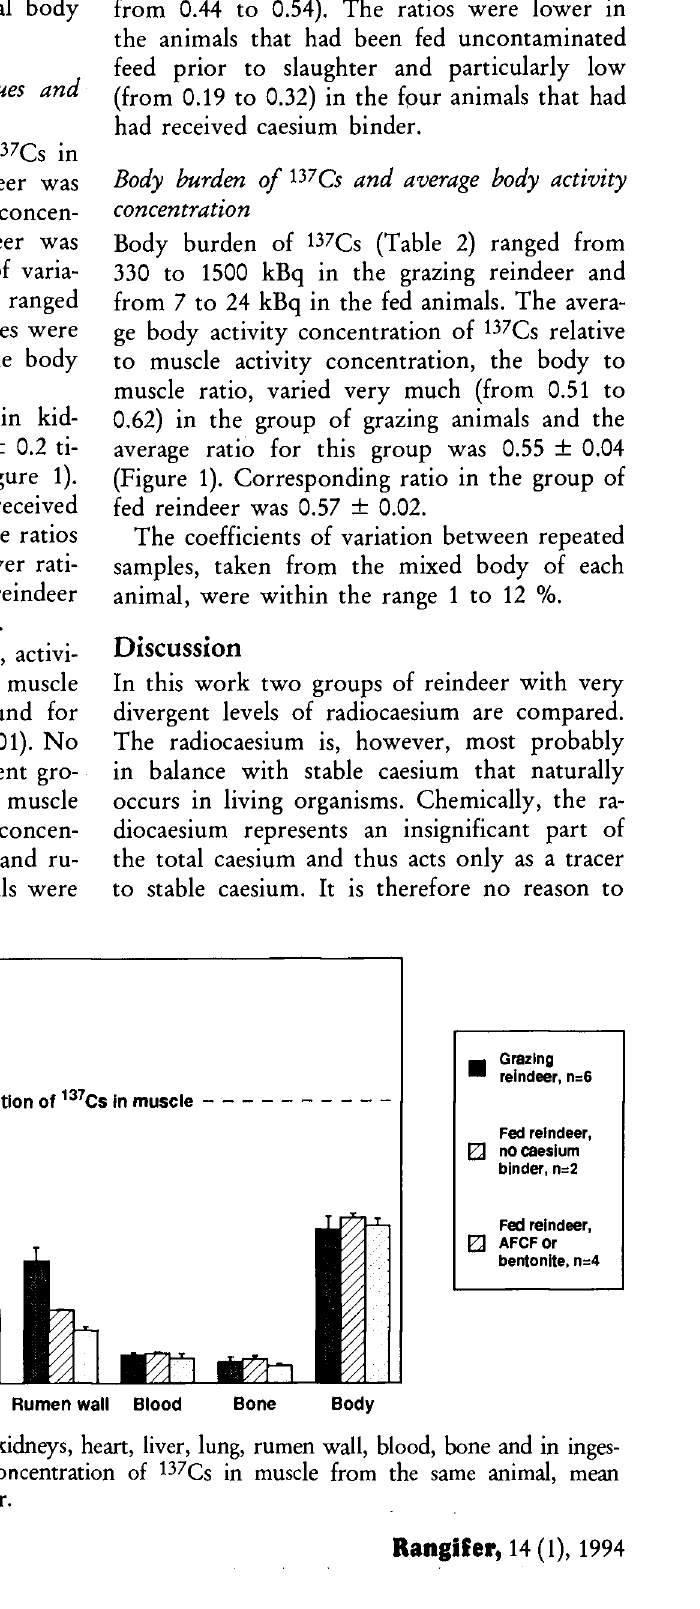
Figure 1. Activity concentration of 137 Cs in kidneys, heart, liver, lung, rumen wall, blood, bone and in inges- ta-free body, relative to activity concentration of 137 Cs in muscle from the same animal, mean ± S.D. for three groups of